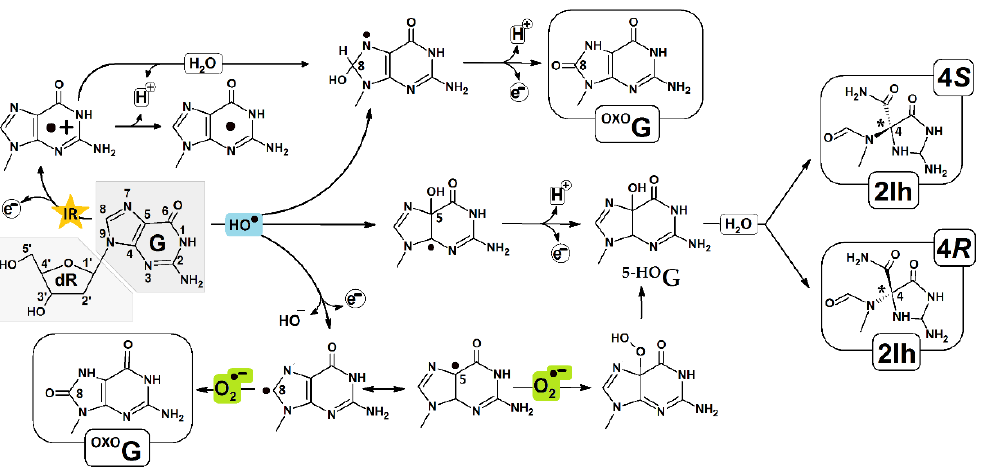
Figure 1. Proposed pathways of 5-carboxamido-5-formamido-2-iminohydantoin (R/S 2Ih) and 7,8- dihydro-8-oxo- 2′ -deoxyguanosine ( OXO G) formation. 7,8-dihydro-8-oxo-2 (cid:48) -deoxyguanosine ( OXO G)